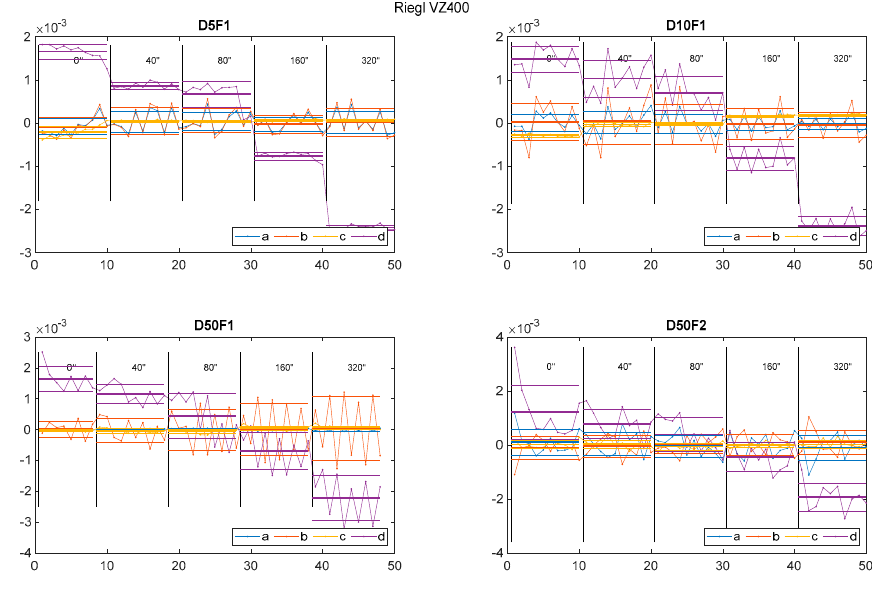
Figure 11. Starting effects of Riegel VZ-400.